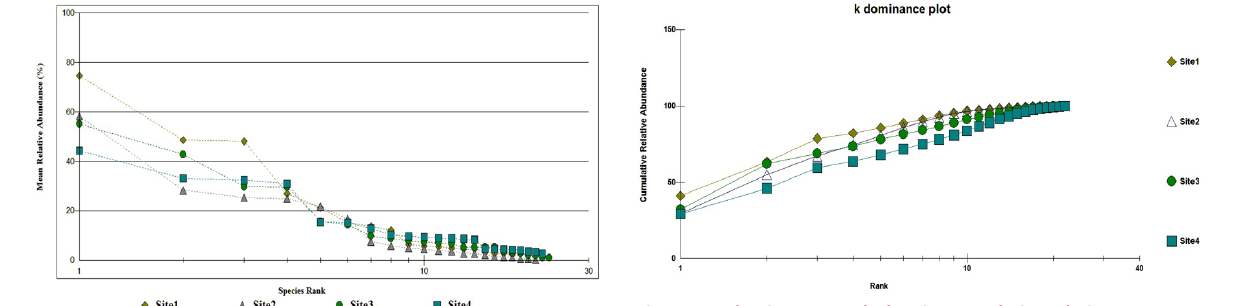
Figure 4. K-dominance graph showing cumulative relative abundance of the aquatic and semi aquatic hemipterans in the four sites of Sonebeel